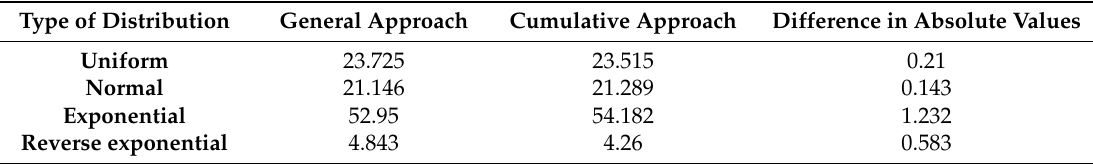
Table 7. Comparison of estimated total number of FL trips per year.